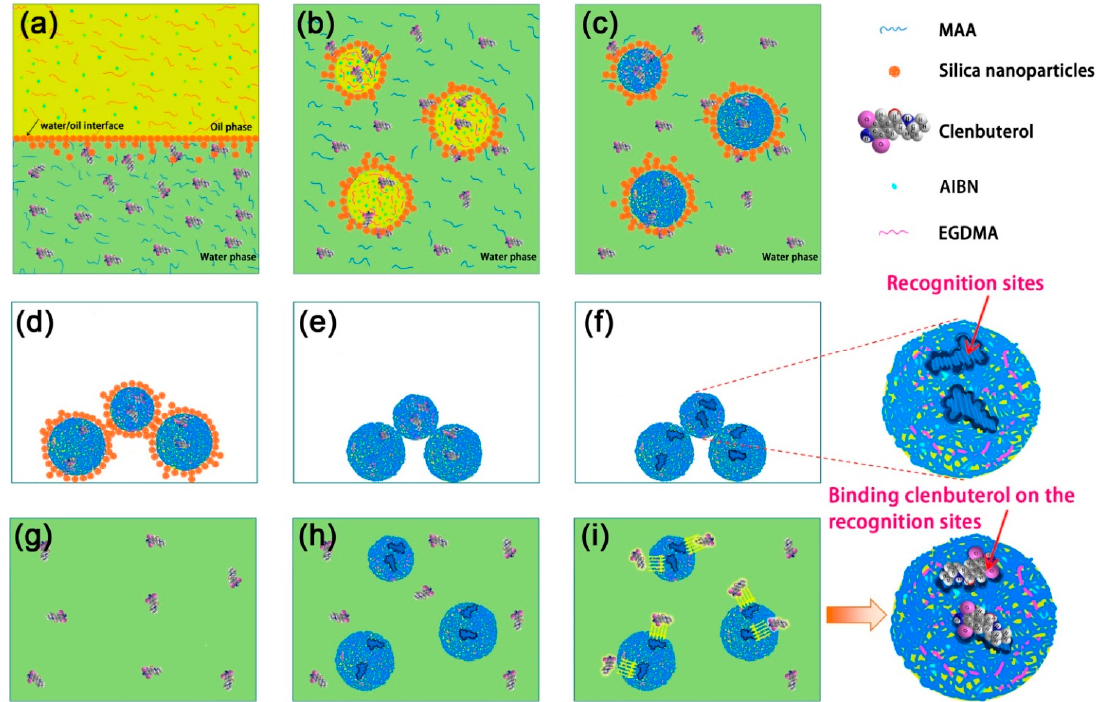
Figure 1. ( a – i ) Schematic illustration of the preparation of molecularly imprinted polymer microspheres (MIPMs) and their enrichment processing of clenbuterol. ( a ) Preparation of the water phase and oil phase containing the reactants needed for the Pickering emulsion polymerization. ( b ) Mixing the two phases to form oil-in-water droplets, where the oil droplets contained the cross-linking agent (i.e., EGDMA), initiator (i.e., AIBN) and part of clenbuterol molecules (as the molecular imprinting agent) and water phase was mainly comprised of the monomer (i.e., MAA); silica nanoparticles were dispersed along the interface between the oil phase and water phase. ( c ) Polymerization of the MAA to form the PMAA cross-linked by EGDMA. ( d , e ) Precipitation ( d ) and thorough washing ( e ) of the cross-linked PMAA microspheres. ( g ) The wastewater contaminated by clenbuterol. ( h , i ) Using MIPs to bind clenbuterol selectively ( i Table 1. Summary of the critical information obtained from the Brunauer–Emmett–Teller (BET) measurements, including BET surface area, the volume of pores, and average pore width. BET Surface Area Volume of Pores Average Pore Width Sample m²/g